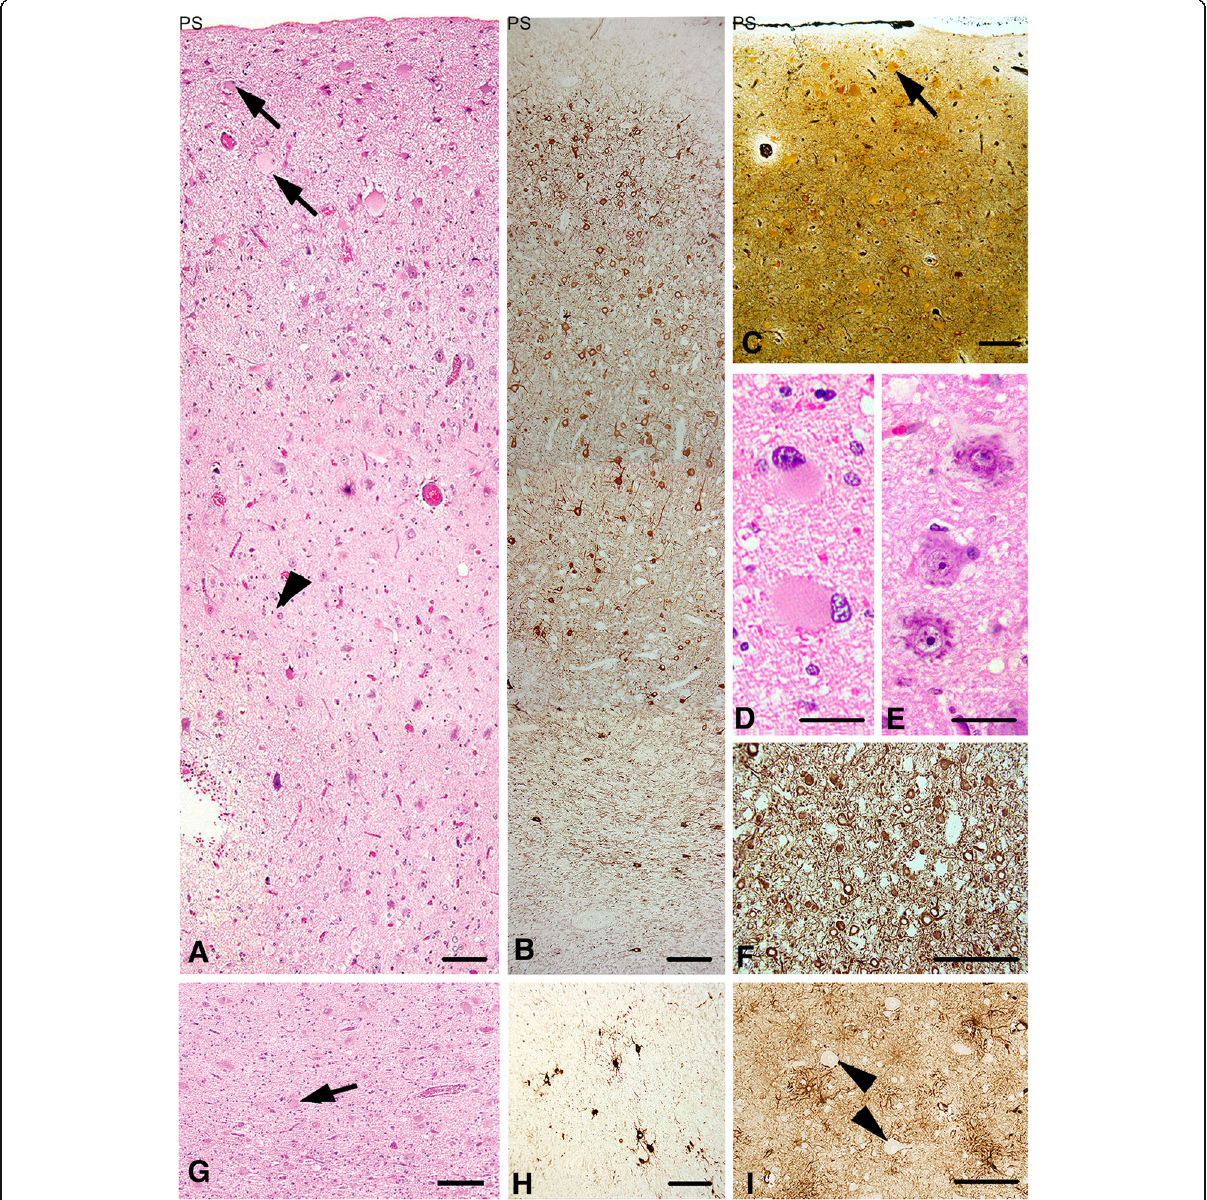
Fig. 1 Histopathologic findings in focal cortical dysplasia type IIb. Sections of frontal cortices resected from epileptic patients showed strongly dysplastic regions, which were characterized by both laminar and columnar architecture disorganization ( a, b, c ). Layer I was observed in most cases ( b ), but in others layer I was populated by abnormal cells ( a, c ). Both BCs (arrows in a, c, d , and g ) and DNs ( e ) were observed, and together with the cortical dysplasia, indicated the diagnosis of FCD type IIb. Frequent findings included: HyNs (open arrowhead in a ), apical dendrites not oriented towards the pia surface (PS) ( b, f ); blurring of the grey-white matter transition ( a, g ); heterotopic neurons in the white matter ( h ), and intense gliosis, shown here in the vicinity of a cluster of large, unstained neurons (arrowheads) ( i ). Cases: 8, a and e ; 10, b, c, f, h ; 1, d and g ; 11, b, i . H&E staining: a, d, e, g ; SMI 311 antibody, b, f, h ; silver impregnation, c ; anti-GFAP antibody, i . Scale bars: 40 μ m: d, e ; 100 μ m: a, b, c, f, h, i ; 200 μ m: